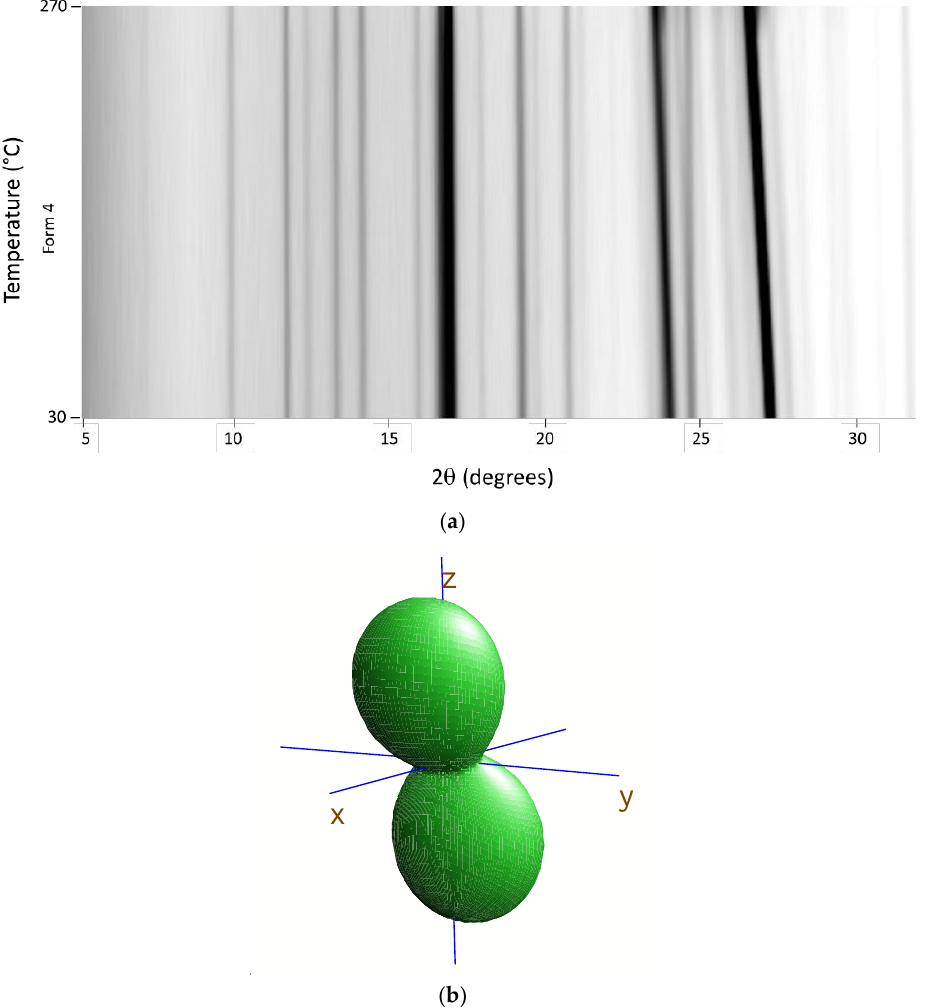
Figure 5. Variable-temperature X-ray diffraction (VTXRD) data (in the full 30 – 270° range) showing the thermal evolution of the XRD pattern upon heating Tafamidis Form 4 in situ in the diffractometer cradle ( a ); note that this form does not suffer from any phase transformation before melting. ( b ) Visualization of the thermal strain tensor, showing a relatively large thermal expansion in the z direction and much smaller (but still positive) components in the xy plane (see text). Note that, for monoclinic symmetry, the y direction in the plot of the tensor isosurface is aligned with b, and that the xz plane corresponds to the crystallographic ac plane.